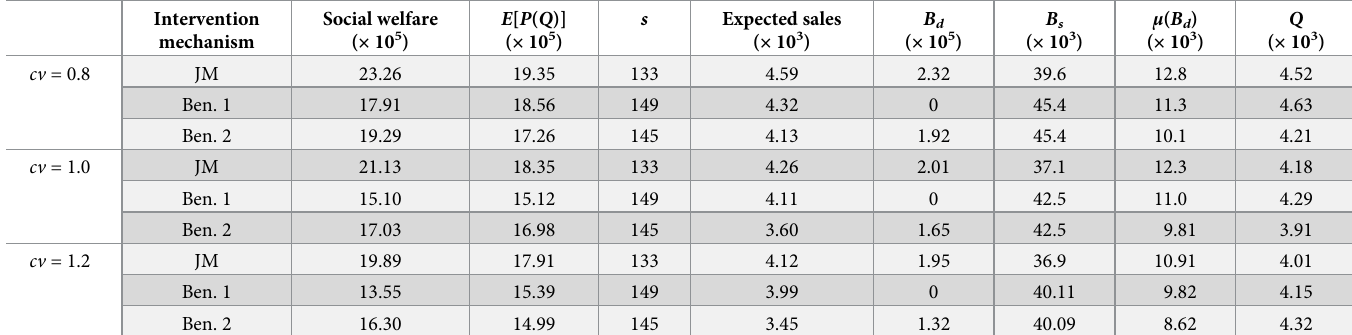
Table 4. The solutions of the basic period given in lognormal distribution. Intervention mechanism